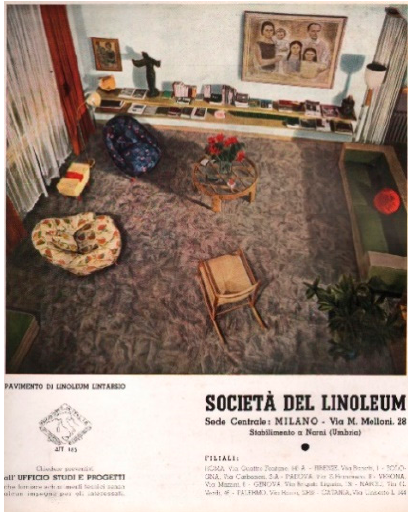
Figure 5. Advertising of Linoleum. Image from Casabella (1937).